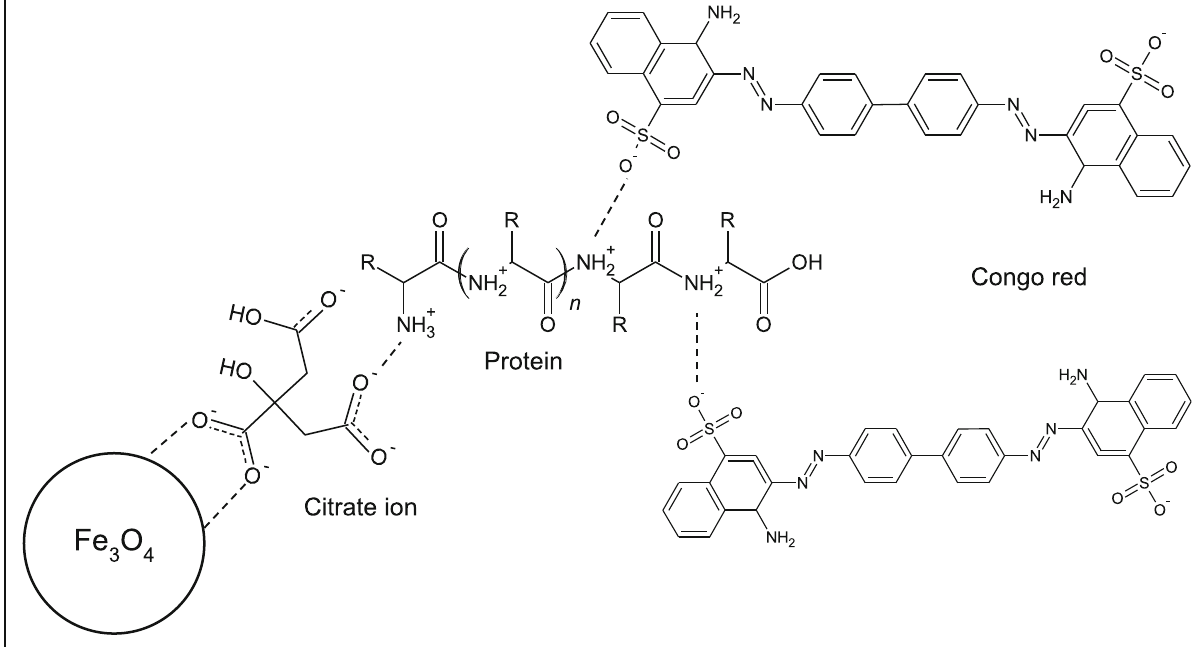
Fig. 7 Illustration of Fe 3 O 4 – CA and protein interaction and charge neutralization coagulation of Congo